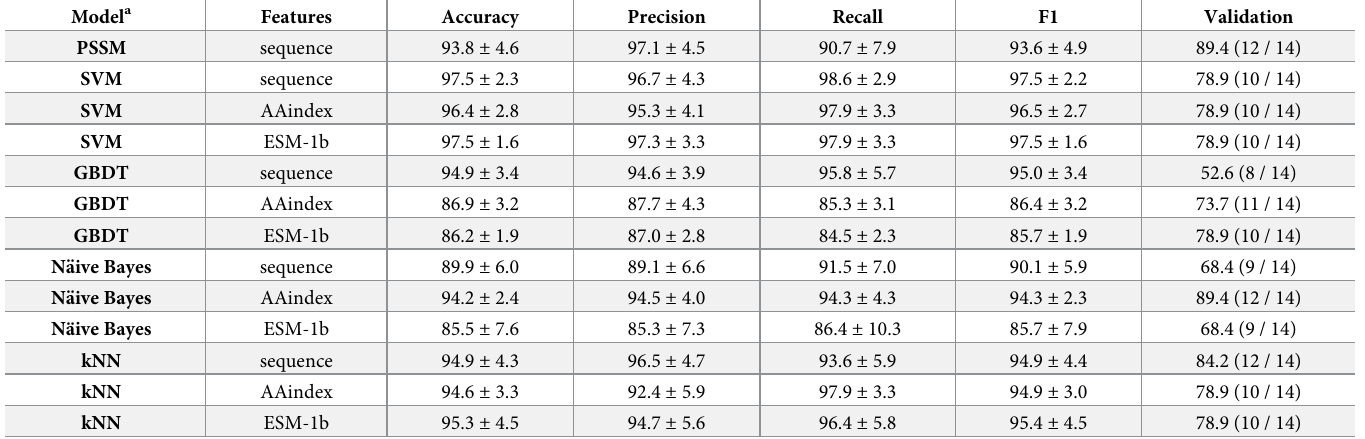
Table 2. Performance of various models for cleavage